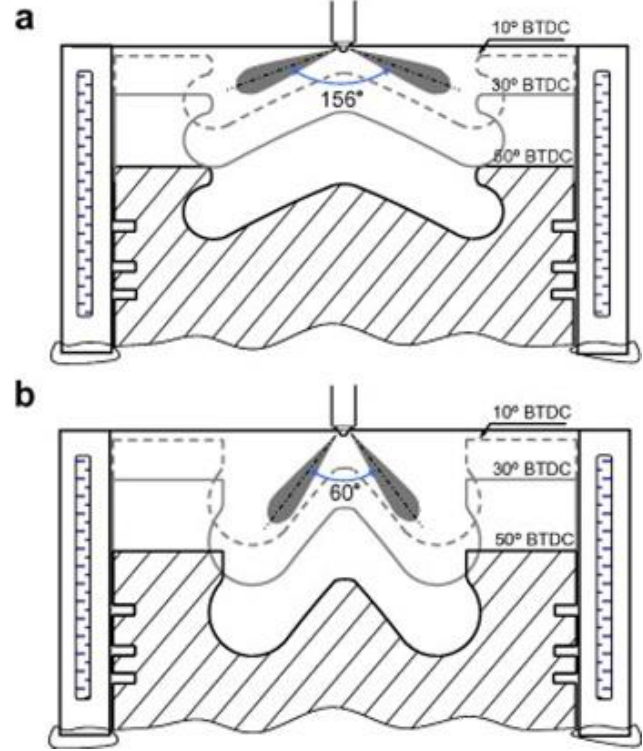
Figure 11. Schematic diagrams of the tested combustion chamber and fuel spray: ( a ) conventional diesel engine; ( b ) modified engine configuration for early injection [62]. diesel engine; ( b ) modified engine configuration for early injection